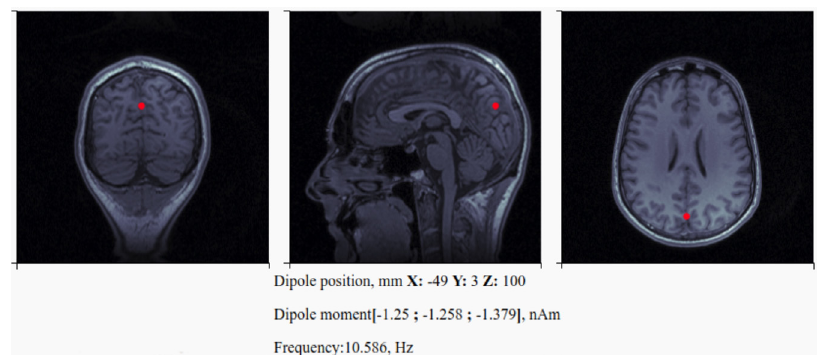
Figure 3. Example of the “Inverse MEG problem” method